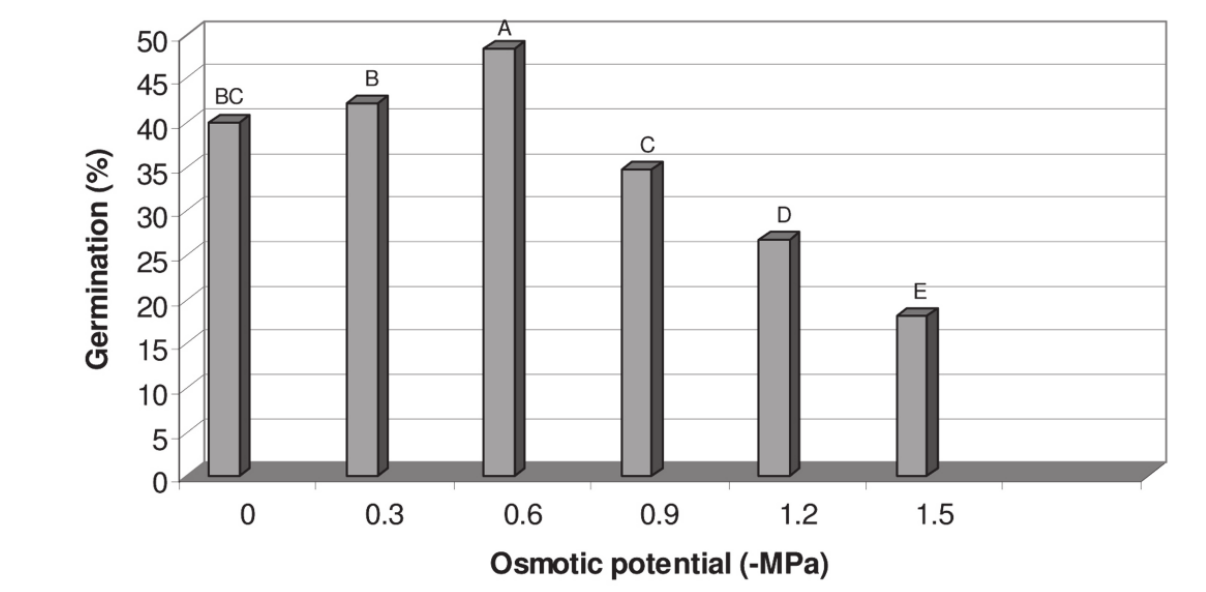
Fig. 1. Effect of osmotic potential on germination (%) of Verticillium dahliae microsclerotia. Significant differences between treatments are indicated by different letters at P ≤ 0.01 by Duncan’s Multiple Range